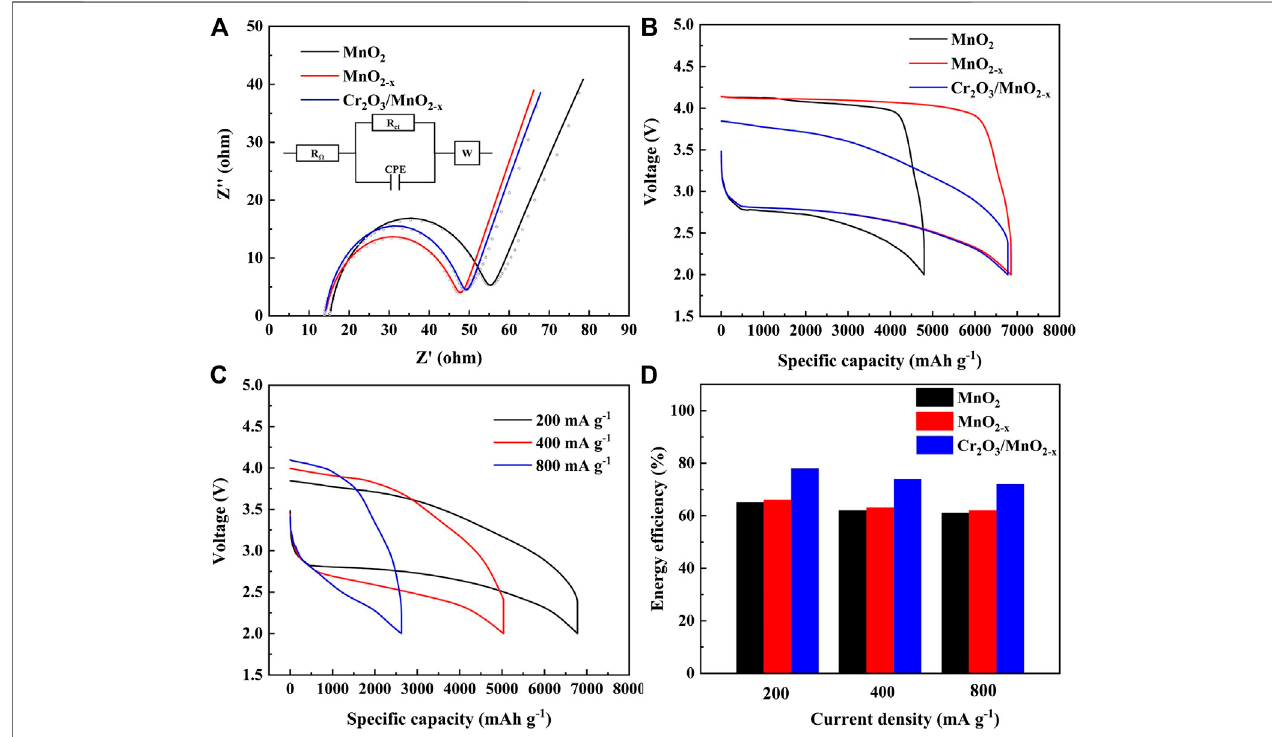
FIGURE 4 | (A) EIS plots and simulated results for different electrode (insert: the equivalent circuit model for EIS); (B) Discharge-charge performances of different electrodes at 200 mA · g − 1 ; (C) High current discharge-charge performances of the Cr 2 O 3 /MnO 2-x electrode; (D) Calculated energy ef fi ciency of different electrodes at different current